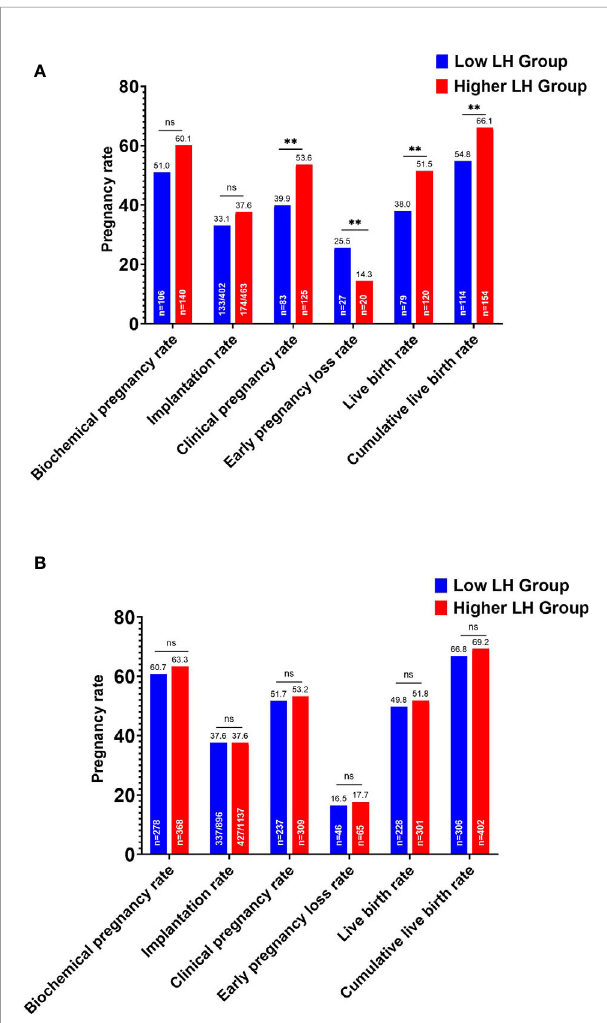
FIGURE 2 | Pregnancy outcomes of the low and higher LH groups strati fi ed by embryo transfer strategy. (A) Pregnancy outcomes after fresh embryo transfers and the cumulative live birth rate for the conventional embryo transfer policy. (B) Pregnancy outcomes after the fi rst frozen-thawed embryo transfers in freeze-all cycles and the cumulative live birth rate for freeze-all policy. ** P < .05. ns, no statistical signi fi